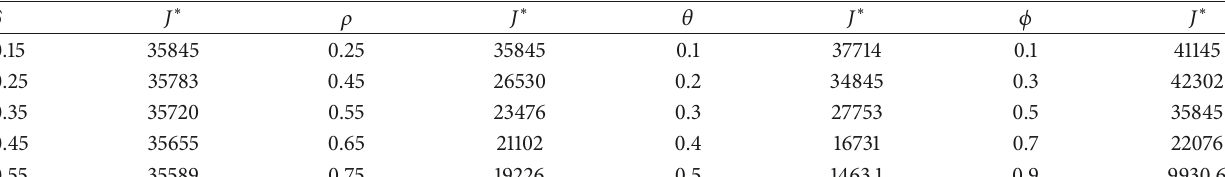
Table 1: Sensitivity analysis of optimal profit 𝐽 ∗ with respect to parameters 𝛿, 𝜌,𝜃 , and 𝜙 .